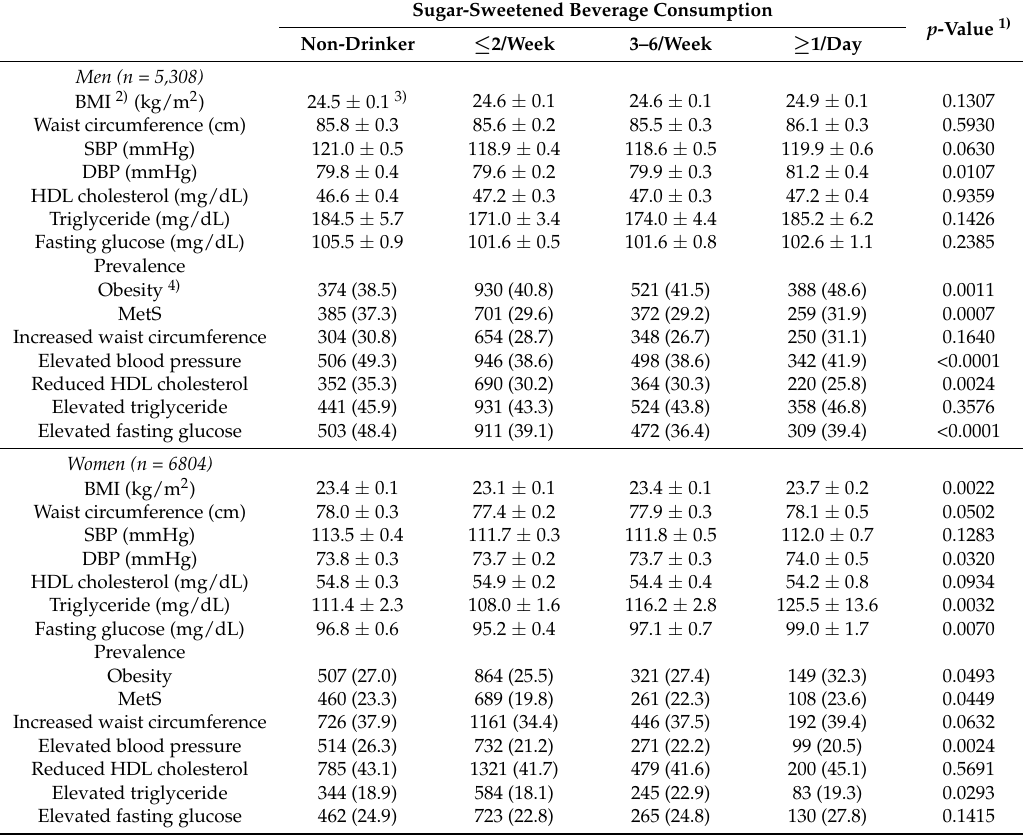
BMI and metabolic syndrome components according to sugar-sweetened beverage